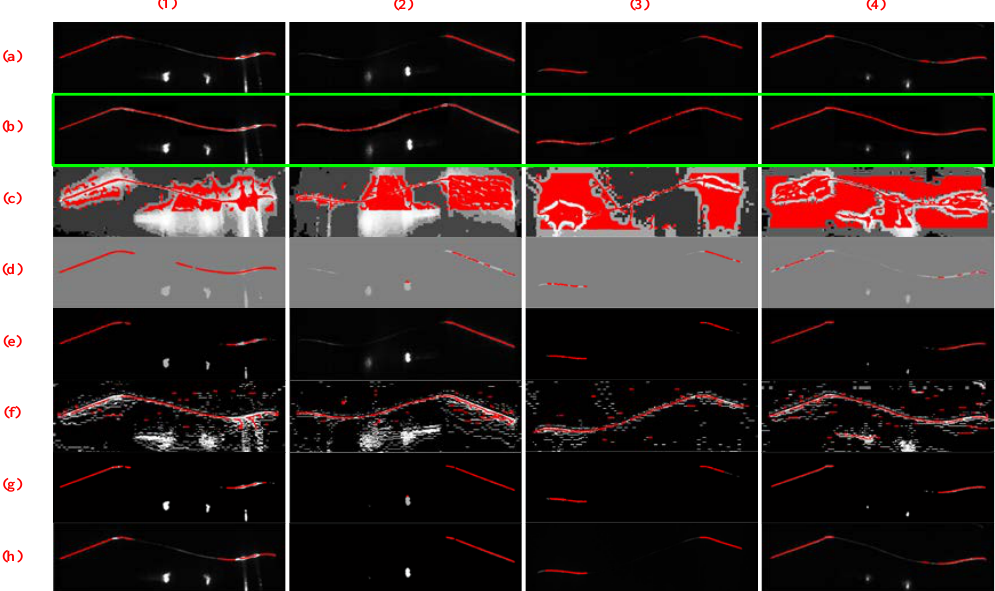
Figure 14. Enhanced results of inner stripe images based on different methods. Columns ( 1 )–( 4 ) present the tread segments with different missing percentages. Row ( a ) displays the raw images. Rows ( b – h ) exhibit the results processed by HE, CA, LT, CF, MF, and SO methods, respectively, and row ( b ) shows the results generated through the proposed method.